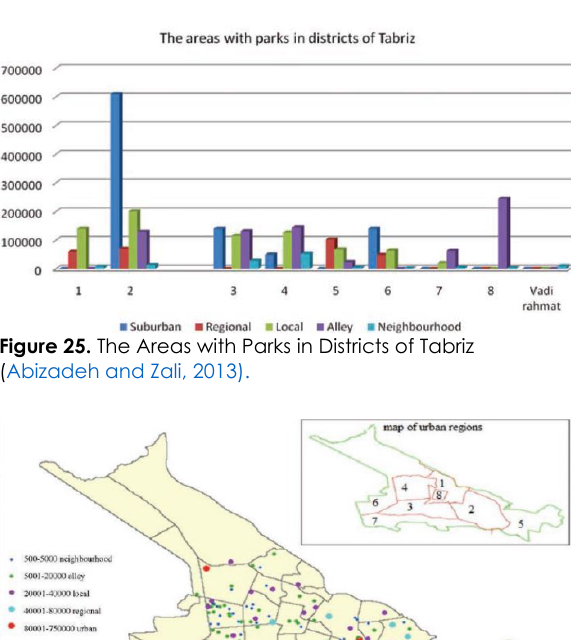
Figure 24. Population Density (Person/ Hectare) in Tabriz (Abizadeh and Zali, 2013).